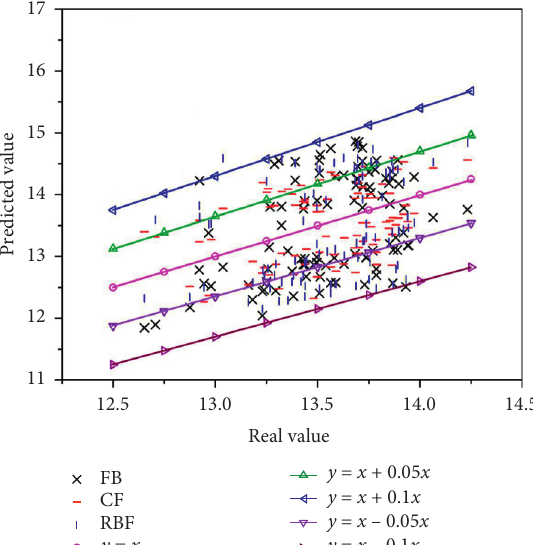
Figure 6: Comparison of prediction errors of A